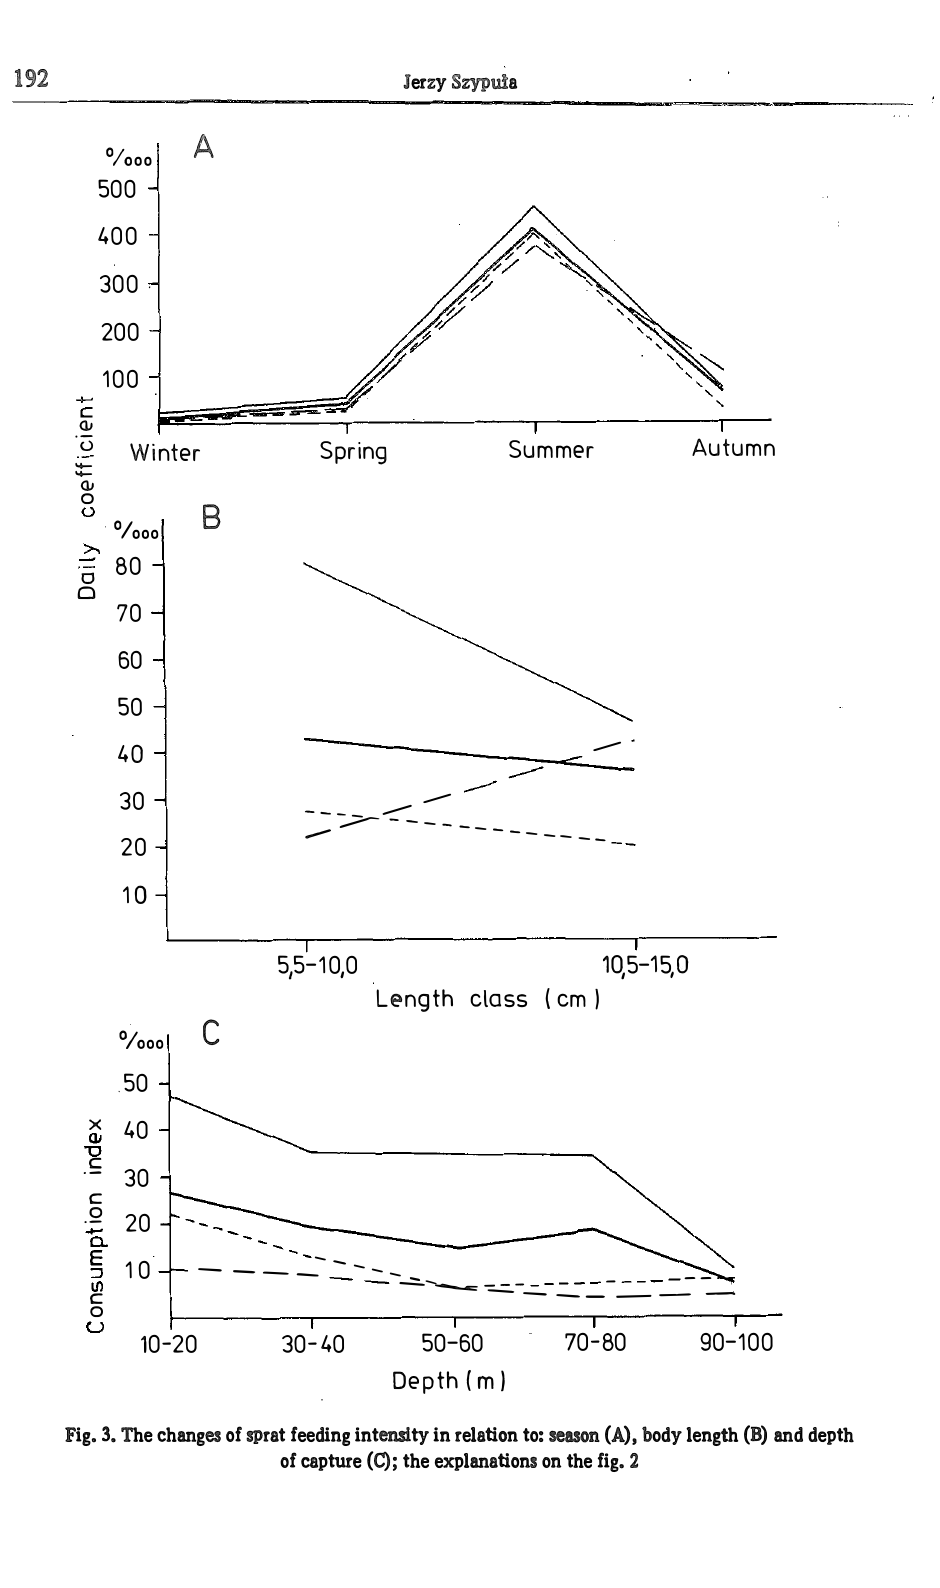
Fig. 3. The changes of sprat feeding intensity in relation to: season (A), body length (B) and depth of capture ( C); the explanations on the fig.